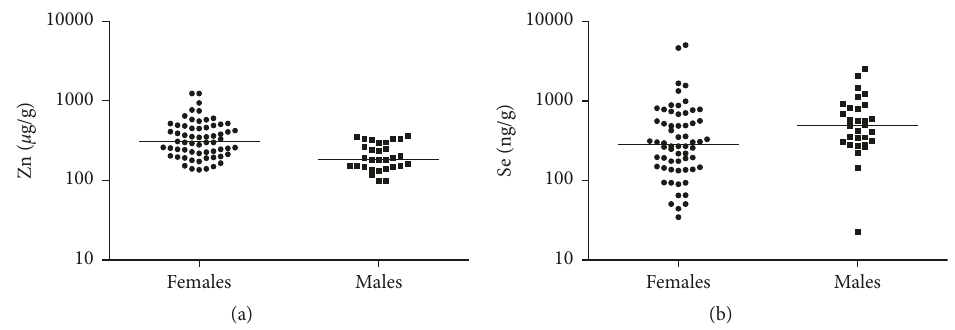
Figure 2: Zinc and selenium concentration in the hair samples of myopic patients depending on gender. Table 6: Spearman’s rank correlation coefficients for control group.